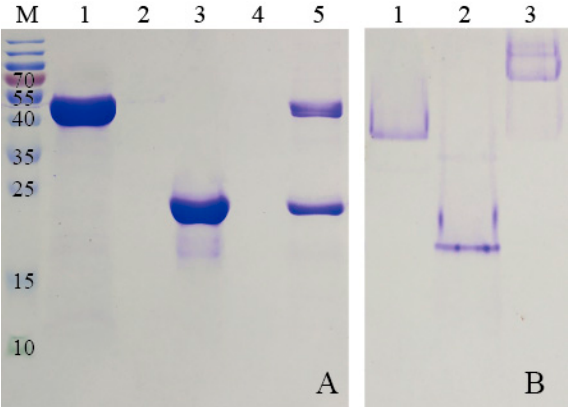
Figure 5. ( A ) Sodium dodecyl sulfate-polyacrylamide gel electrophoresis (SDS-PAGE) showing the interactions between HE and KG. Lane M: protein marker. Lane 1, KG; lane 2, elution fraction; lane 3, HE; lane 4, elution fraction; and lane 5, elution of KG-HE. ( B ) Non-denaturing polyacrylamide gel electrophoresis (Native PAGE) showing the interactions between HE and KG. Lane 1, HE; lane 2, KG; lane 3, KG-HE complex.